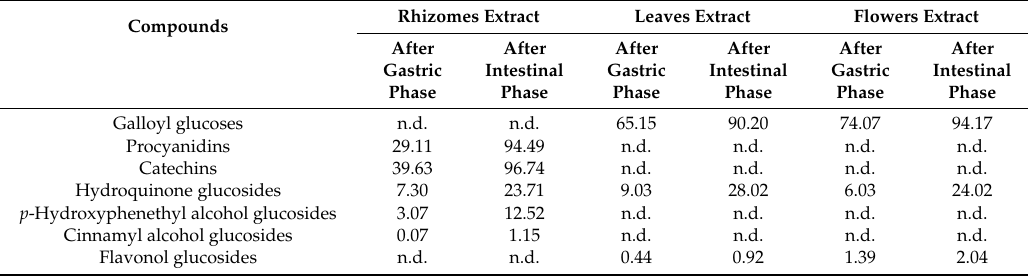
Table 7. Percentage reduction of selected marker compounds in R. rosea extracts after in vitro treatment by the simulated gastric and intestinal media.